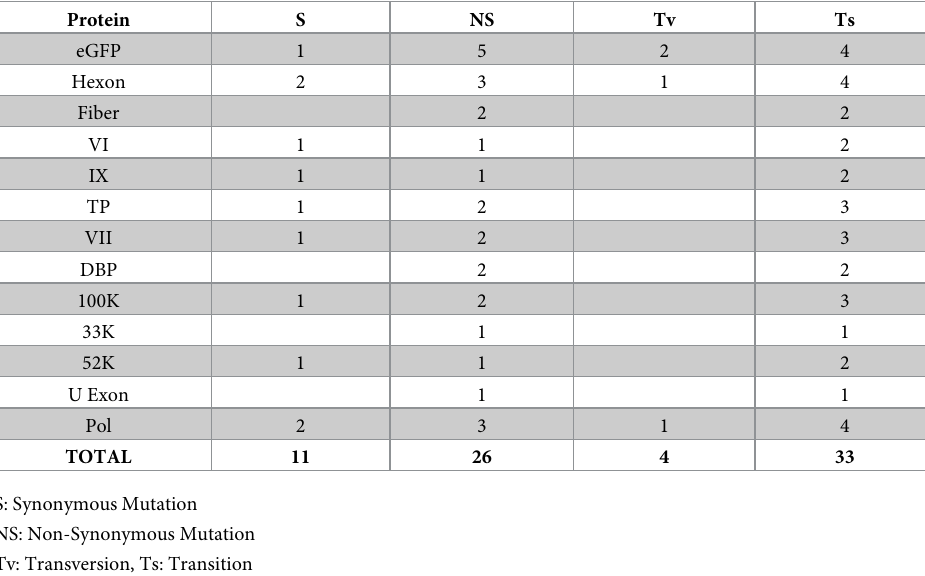
52K protein (H193Y), and IIIa (A39) reached a frequency of > 50%; however, none of these mutations stayed above this threshold (Fig 1B). In contrast, mutations in polymerase (R149H, P132, and C228), the U Exon (G5D), hexon (I114K and E154K), and L4-100K (G745D) became fixed in the population as early as the 15 th round of selection (Fig 1A and 1B). In addi- tion, a third mutation in hexon (E424K) was trending towards fixation (Fig 1A). Each of the hexon mutations introduced positive charge in one of two hypervariable regions (HVRs), HVR1 (I144K and E154K) or HVR7 (E424K), located on the outer face of hexon (Fig 2C); therefore, we focused on their contribution to HD5 resistance. We plaque purified viruses with one, two, or three of these hexon mutations in combination with the L4-100K mutation. We were unable to isolate viruses that contained only hexon mutations in the absence of the L4-100K mutation, perhaps due to the role of this protein as a chaperone for the proper fold- ing, trimerization, and transport of hexon [25,26]. Thus, we engineered a virus containing both HVR1 mutations in the absence of the L4-100K mutation. Viruses that contained only the mutation in L4-100K had an IC equivalent to that of HAdV-5 (Fig 2A, salmon). Viruses 50 with the L4-100K mutation and only one (pink) or both (blue) of the hexon mutations in HVR1 had a significantly higher IC compared to the starting population but were equivalent 50 to each other. The presence of all three hexon mutations (green) resulted in a ~3-fold increase in IC from the starting population. Interestingly, the virus engineered with the two muta- 50 tions in HVR1 but without the mutation in L4-100K (purple) was just as resistant to HD5 as viruses with all three hexon mutations and L4-100K. Taken together, these results indicate an important role for HVR1 and HVR7 in sensitivity of HAdV-5 to neutralization by HD5. Table 1. Number of mutations found at > 1% frequency at any point during selection with HD5.